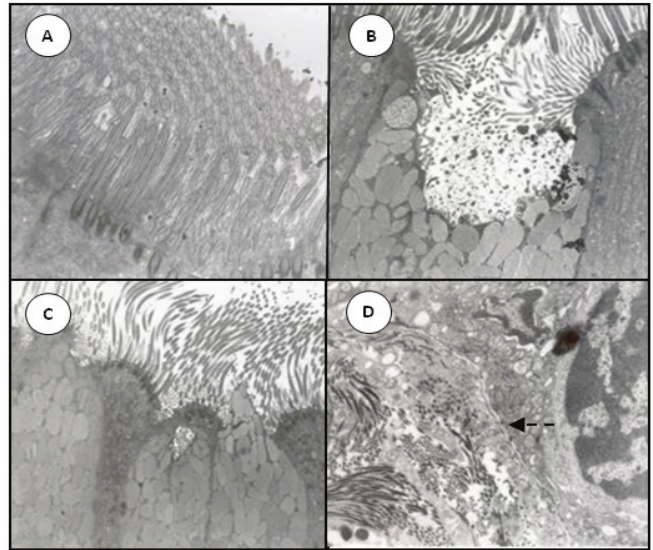
FIGuRE 6 - Control dog. Medial trachea. Transmission electron microscopy showing abundance of the ciliated cells and normal aspect of the cilia ( A – x 17,000); goblets cells and ciliated cells ( B – x 13,250 ; C – x 5,750); intact and continuous basement membrane (arrow; d – x 17,000).